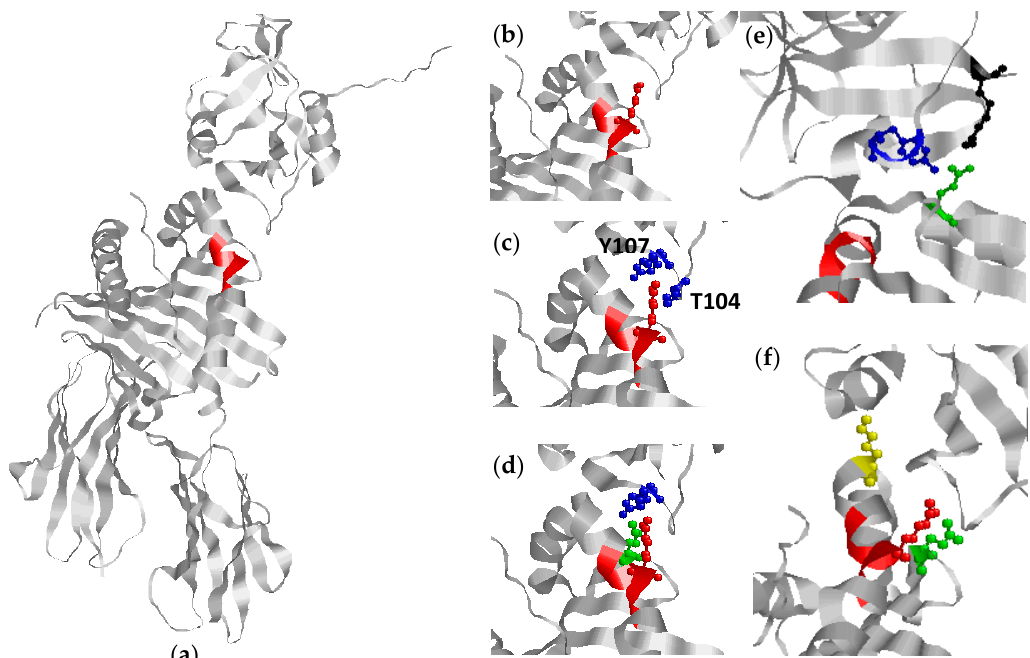
Figure 3. Interactions between gp42 and HLA-DR1: ( a ) crystal structure of the HLA-DR1 and gp42 complex. The shared epitope backbone structure (amino acids 70–74) is colored in red; ( b ) location of Arg72 in the shared epitope; ( c ) interaction between Arg72 (HLA-DR1) and T104 (blue) and Y107 (blue) of gp42; ( d ) interaction between E46 (green) and Arg72 (red) (HLA-DR1) and Y107 (blue) (gp42) through a salt bridge and hydrogen bonding, respectively; ( e ) interaction between E46 (green) (HLA-DRB1) and R220 (black) and Y107 (blue) (gp42); and ( f ) location of E46 (green), I67 (yellow), R72 (red) in HLA-DRB1.